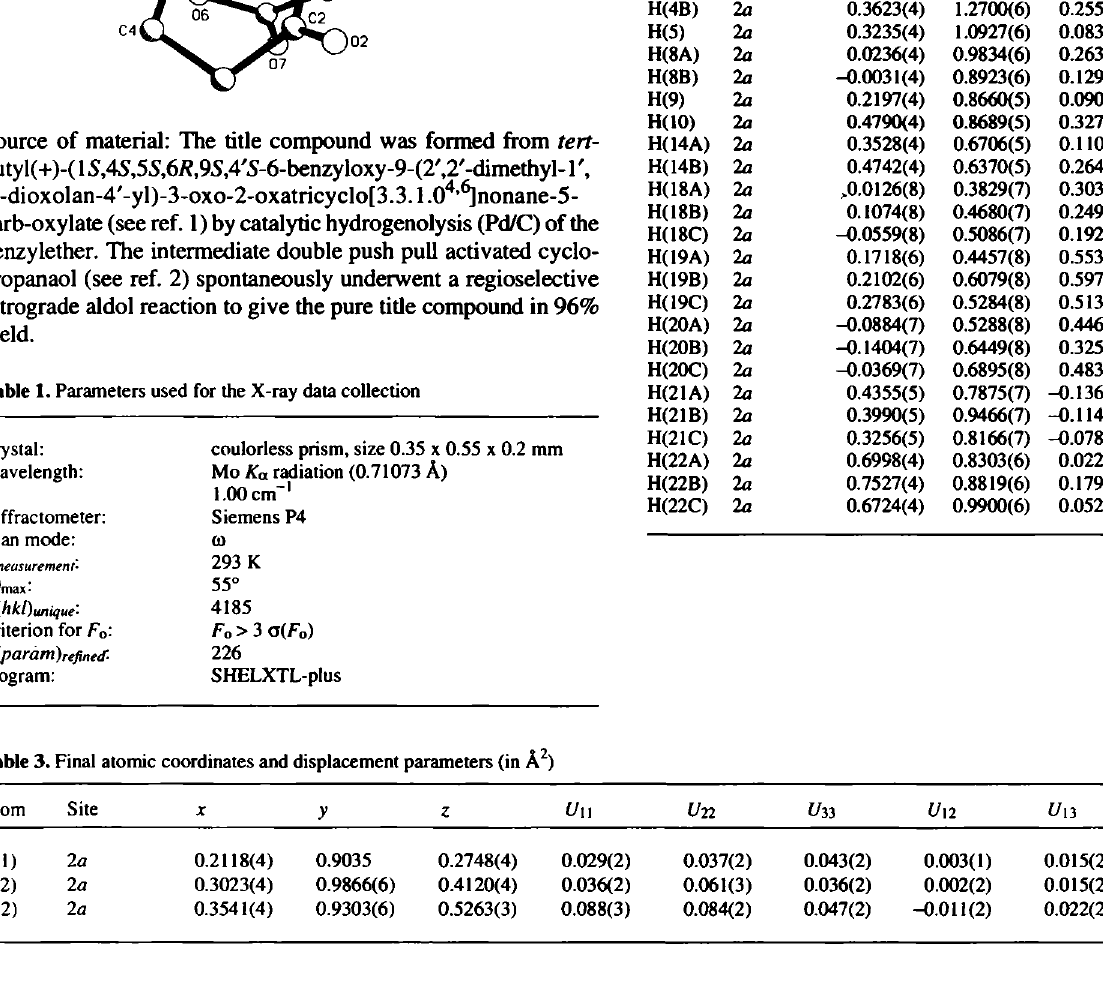
Table 2. Final atomic coordinates and displacement parameters (in Â^)